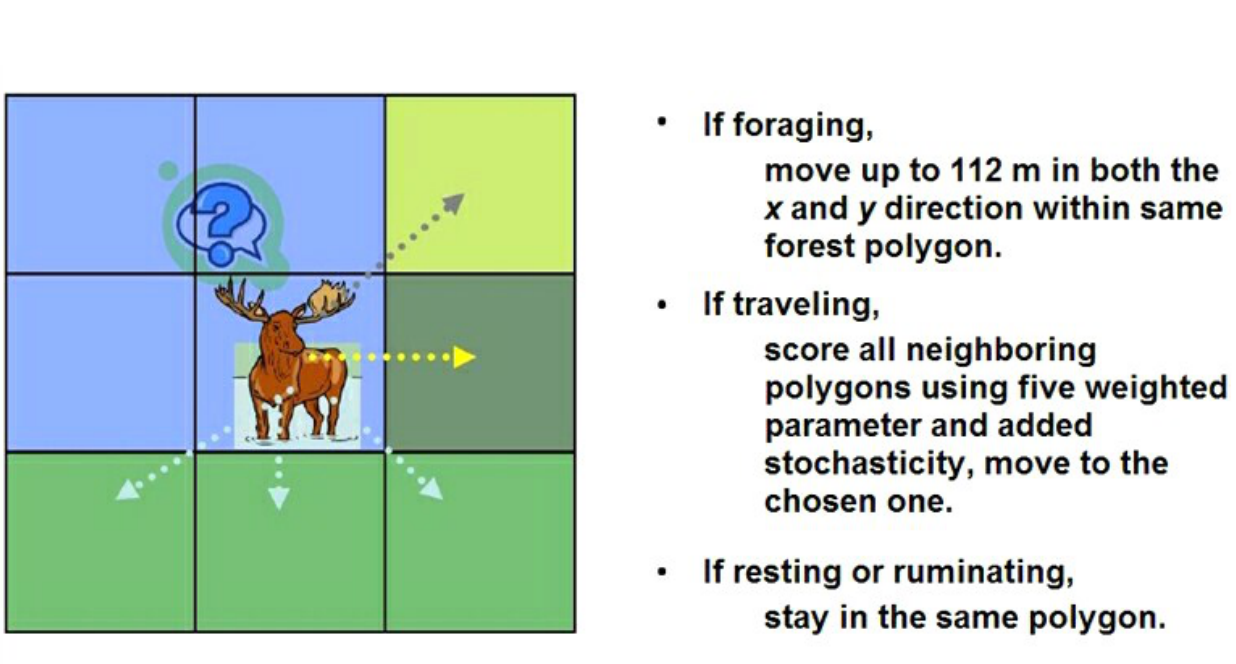
Fig. 4 . Moose movement